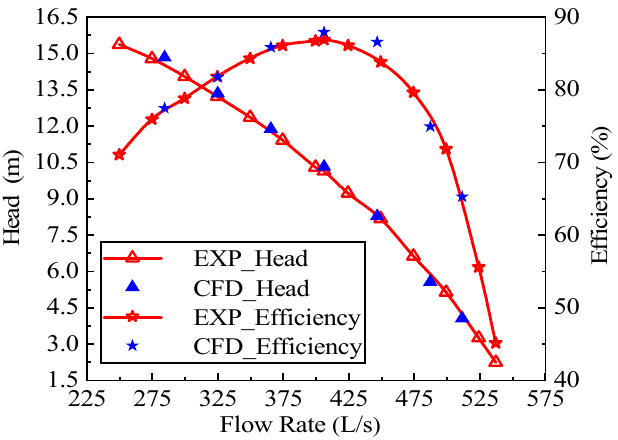
Figure 6. Performance comparison of numerical simulation and model test.